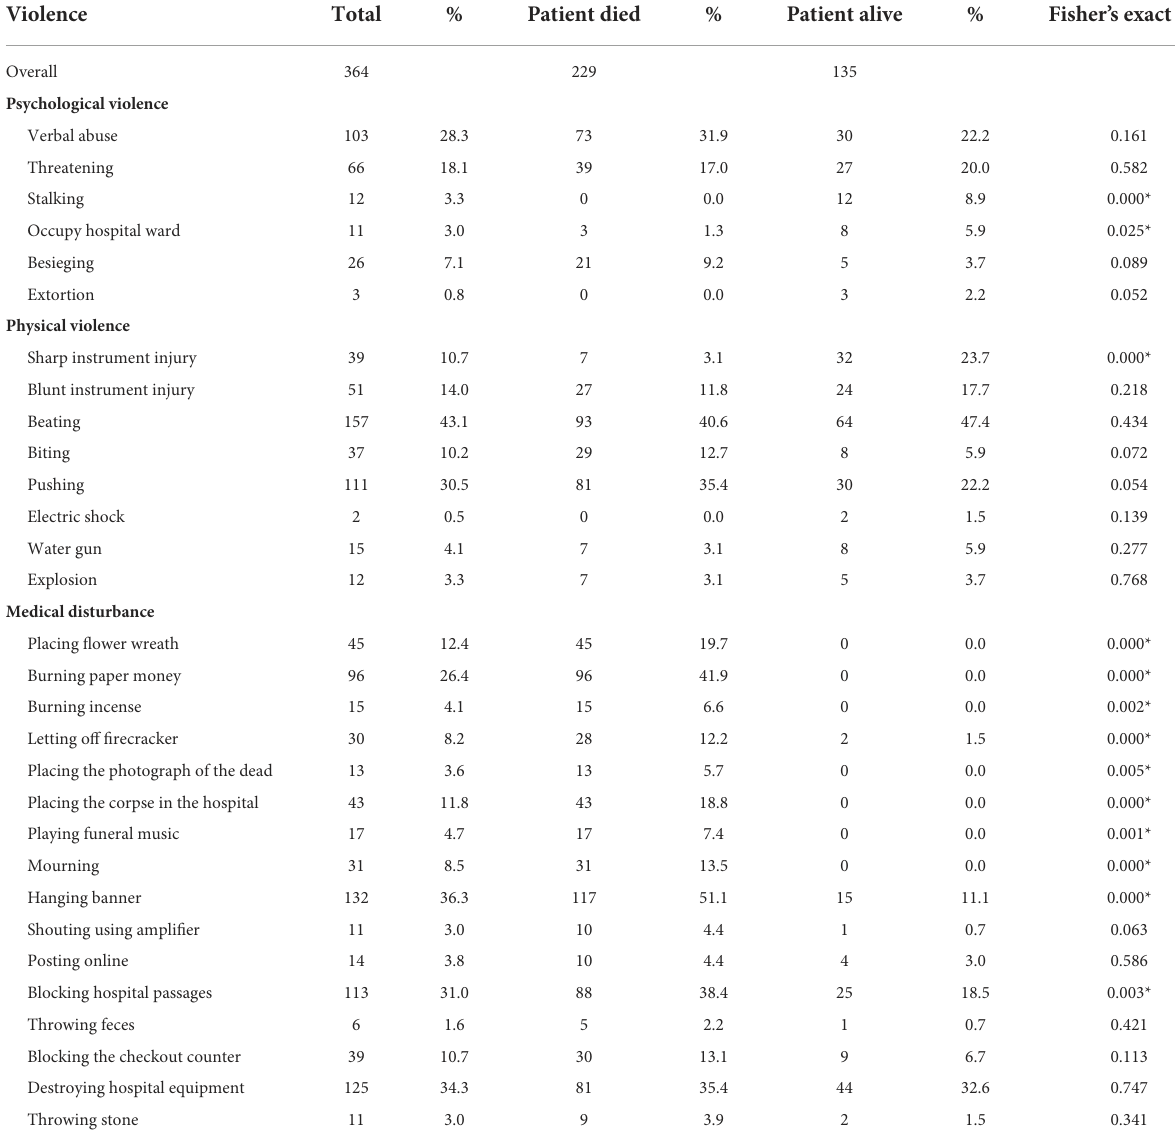
TABLE 3 Types of violence in the judgement